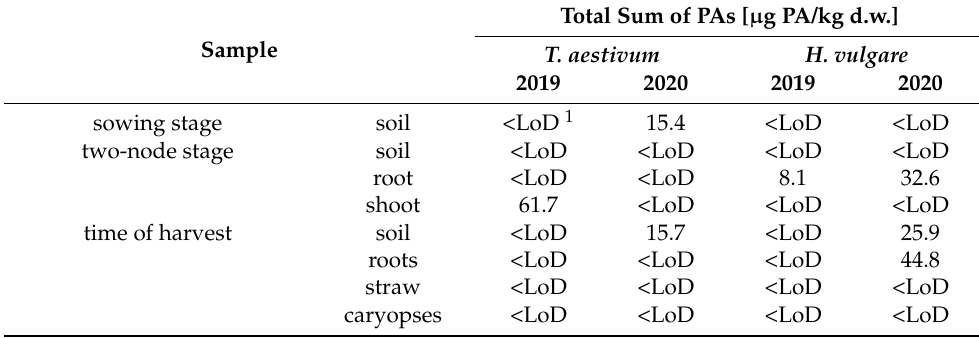
Table 5. PA-content of follow-up crops ( T. aestivum and H. vulgare ) on plots used for the cultivation of L. squarrosa two years